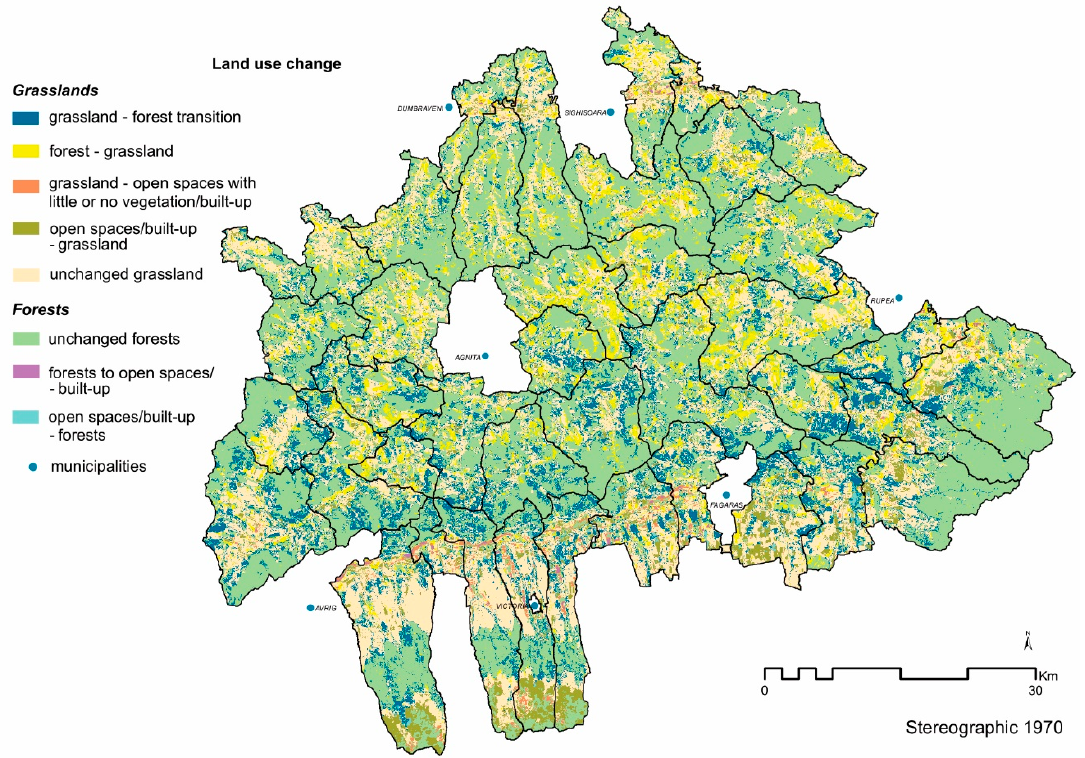
Figure 3. Land use changes during the period of 1985–2003 determined by using Landsat data .